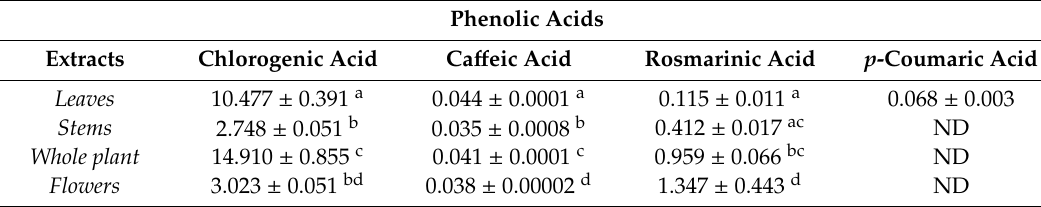
Table 2. Quantitative composition (mg / g of DW) of determined phenolic acids in E. ciliata ethanolic